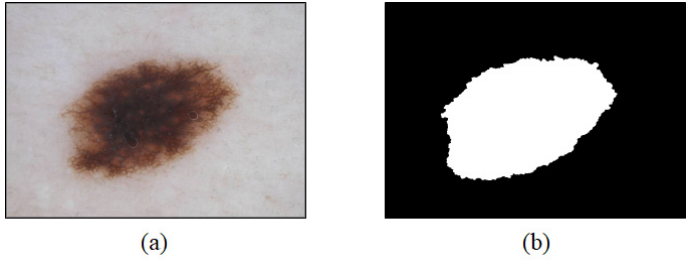
Figure 2. Examples of an image ( a ) obtained based on dermoscopy and an image and ( b ) obtained based on binary splitting.